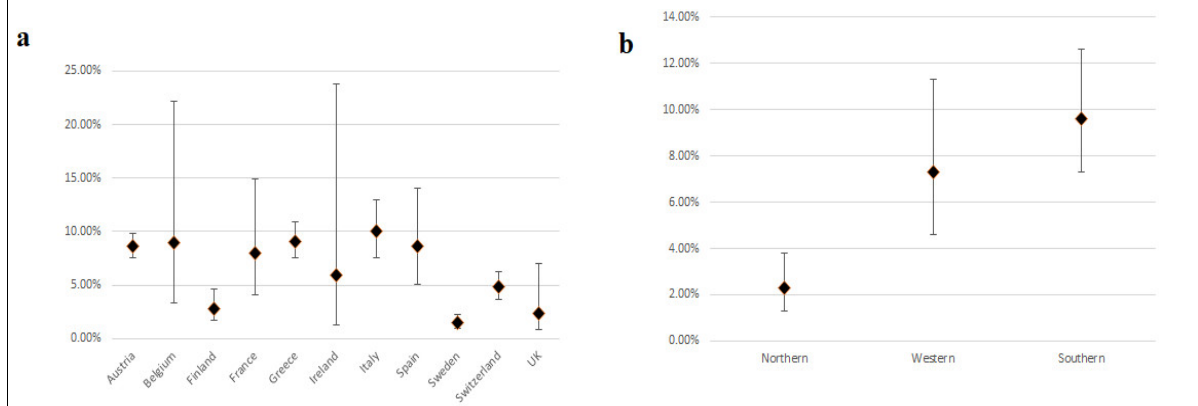
Figure 2. Mean GDM prevalence and 95% CI in: ( a ) 11 European countries; ( b ) Northern, Western, and Southern Europe.